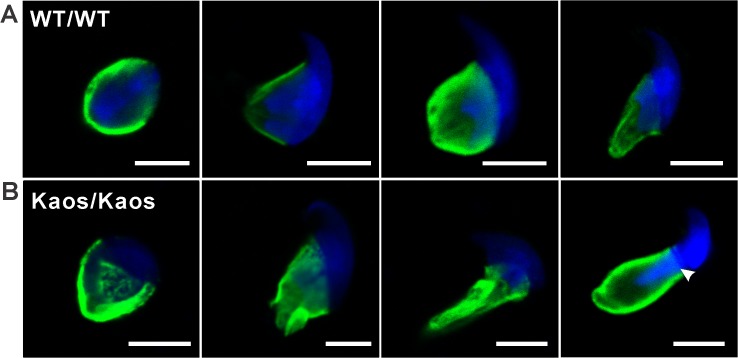
Manchette structure in Lrguk
WT/WT and Lrguk
Kaos/Kaos elongating spermatids.α-tubulin staining (green) of manchette microtubules in elongating spermatids from Lrguk
WT/WT
(A) and Lrguk
Kaos/Kaos mice (B) are shown in progressive steps during head elongation. Nuclei were stained with DAPI (blue). The scale bar = 5 μm. Please see S3 Fig. for negative control images.